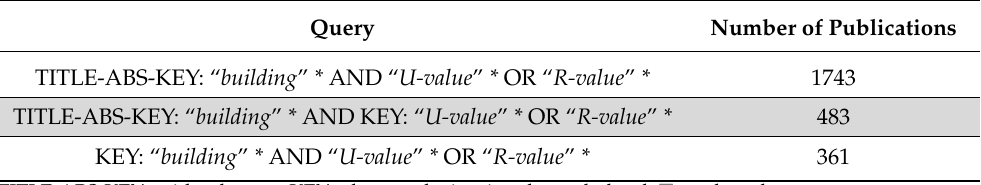
Table 1. Queries used and number of publications obtained for the topic “ thermal transmittance assessment of building* ” (source: authors’ elaboration, 16 March 2023).